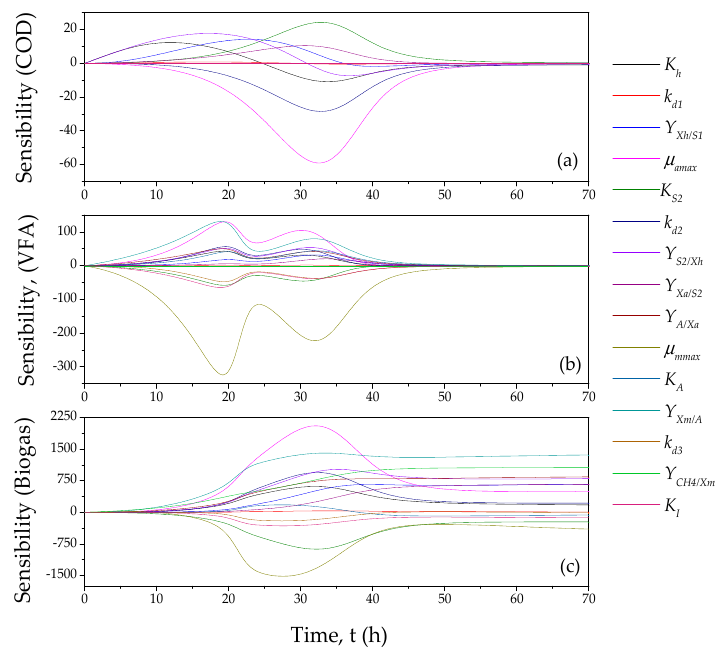
Figure 4. Local sensitivity analysis for: ( a ) COD, ( b ) VFA and ( c ) biogas.